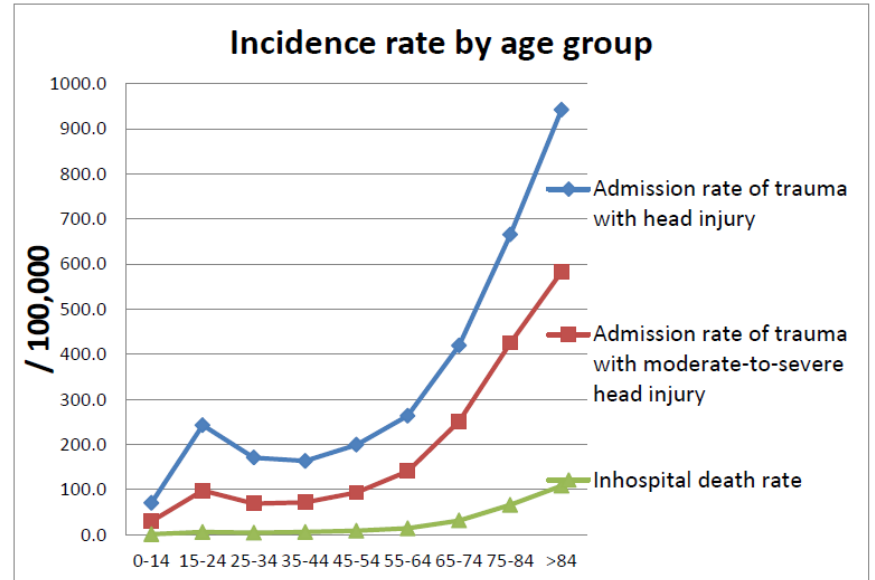
Figure 1. Incidence rate of head injury admission and death by age groups.